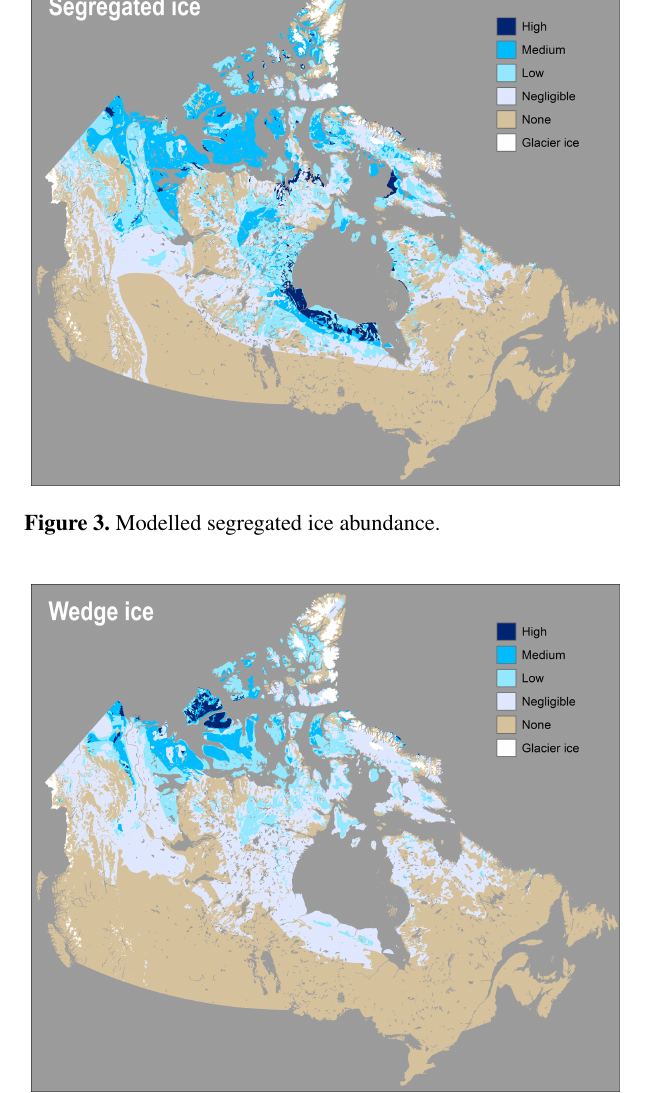
Figure 4. Modelled wedge ice